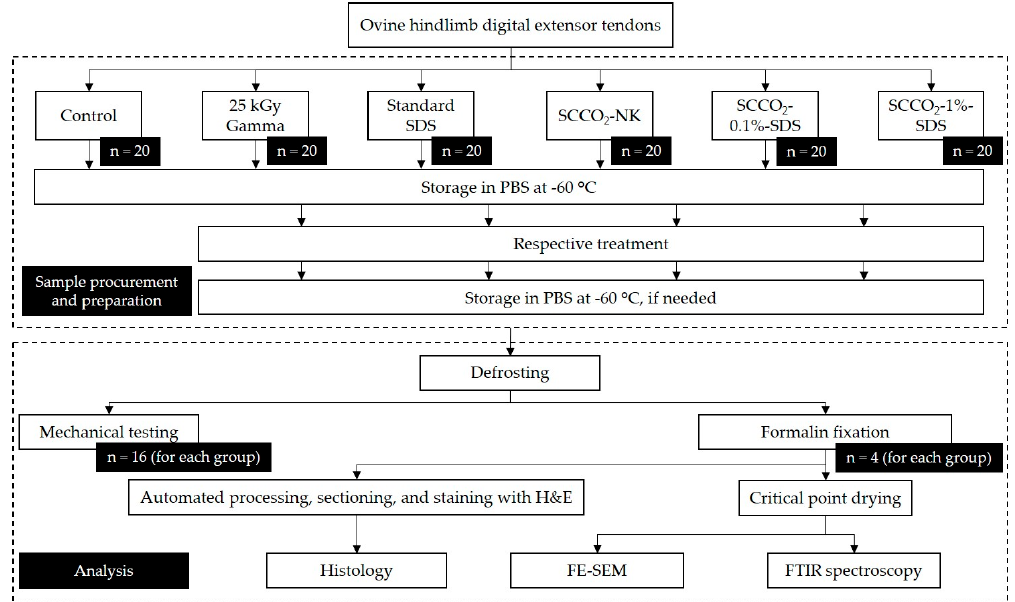
Figure 5. A study design flowchart showing the sample size for each group and endpoint, and processing and storage steps. Abbreviations: SDS, sodium dodecyl sulfate; SCCO 2 , supercritical carbon dioxide; PBS, phosphate-buffered saline; FE-SEM, field-emission scanning electron microscopy; FTIR, Fourier-transform